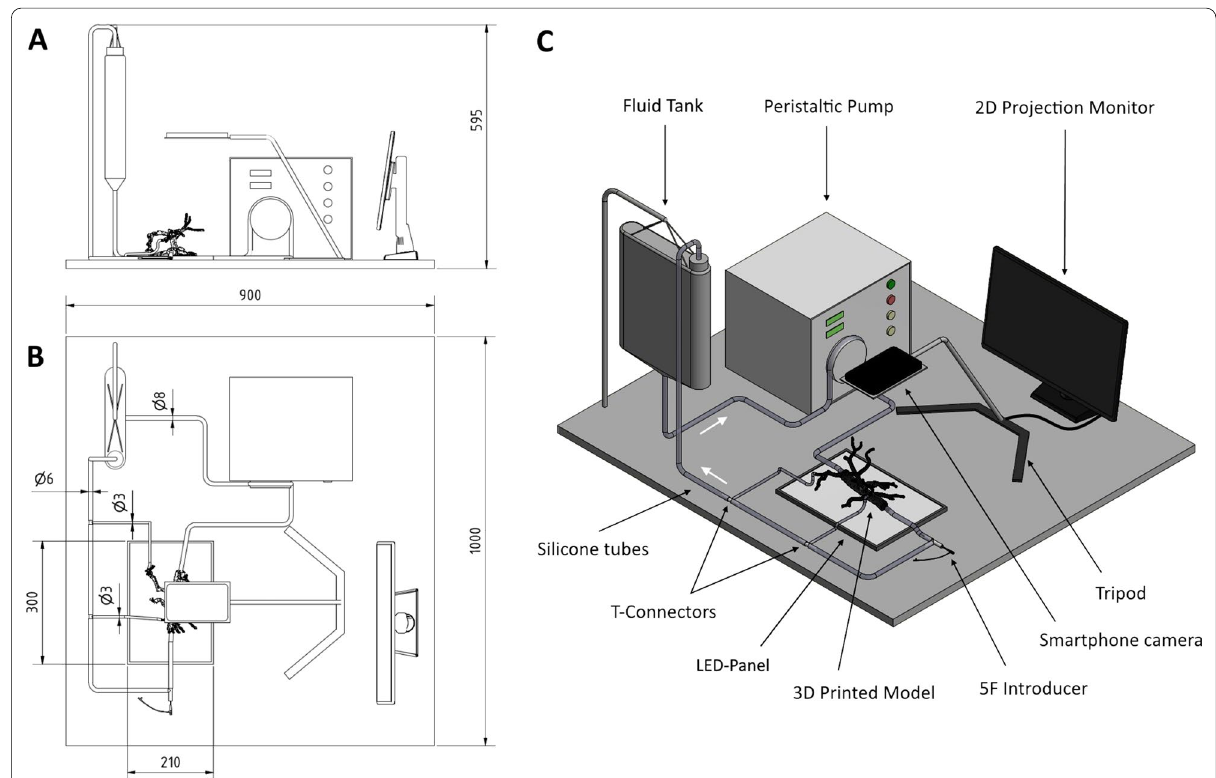
Fig. 1 Technical illustration of the adaptable endovascular simulation setup. A patient-specific 3D printed vascular model is connected via silicone tubes to a peristaltic pump to establish a closed pulsatile circulatory system. The 2D projection in angiography is simulated with a smartphone camera on a tripod projected on a monitor. A Lateral view, B top view, C 3D visualization. Units: